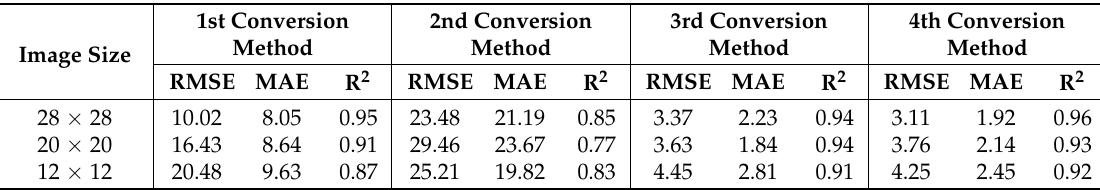
Table 2. Prediction performance of the CNN model through different image sizes and methods.